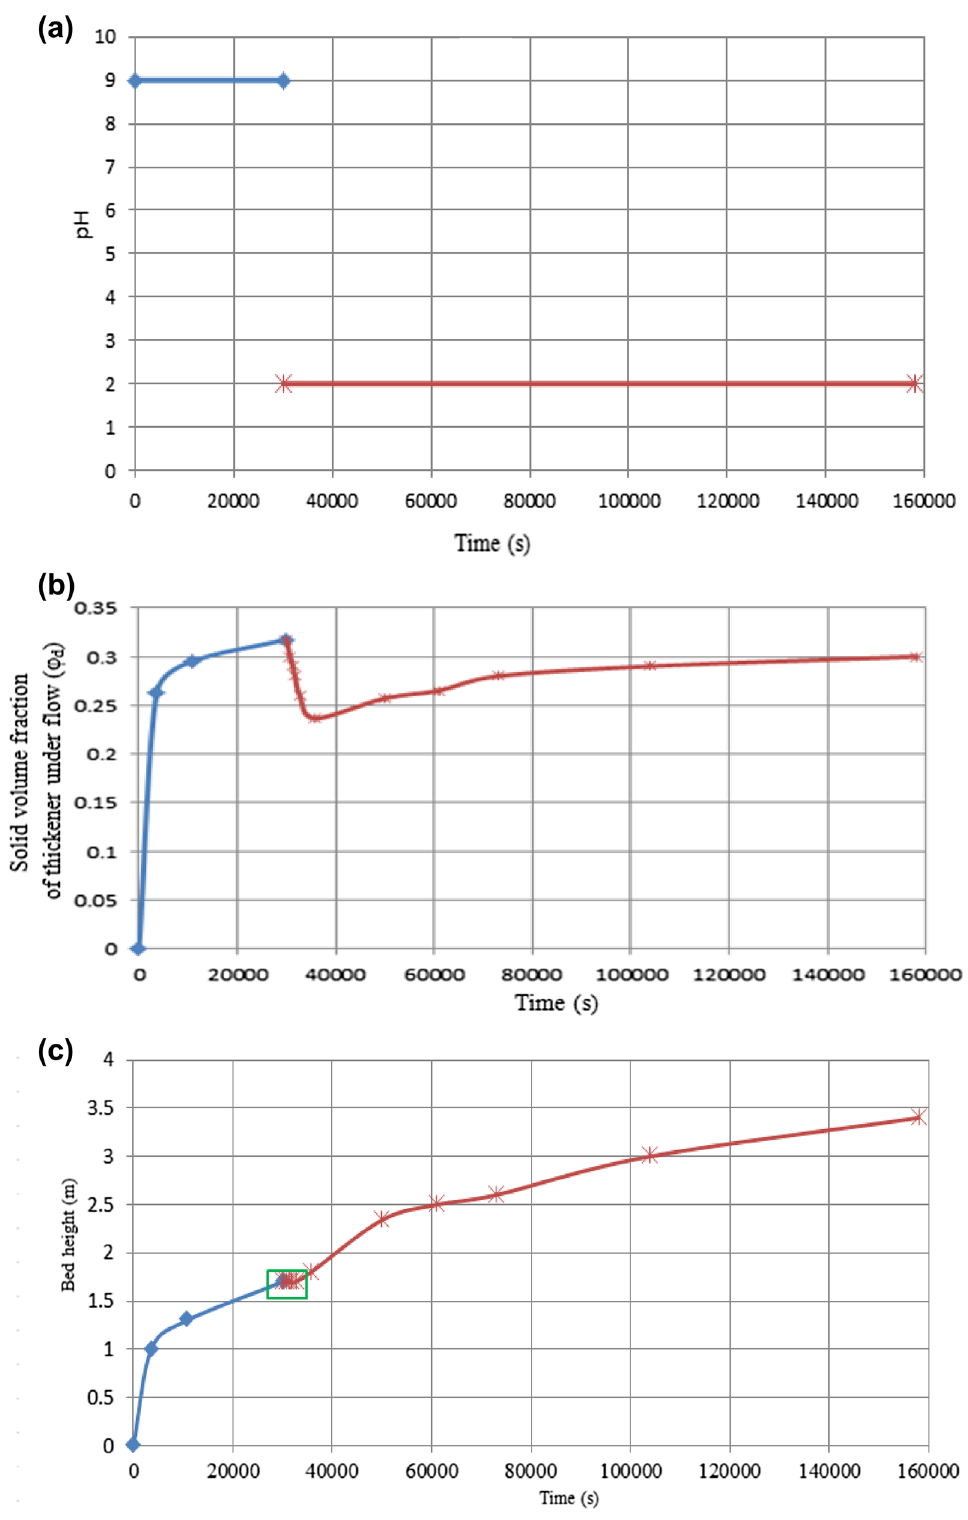
Fig. 2 The time-dependent variation of pH of input feed to thickener and simulation of changes of response variables for the conditions: d 80 = 275 l m, F = 40 g/t, First pH 9 and then pH